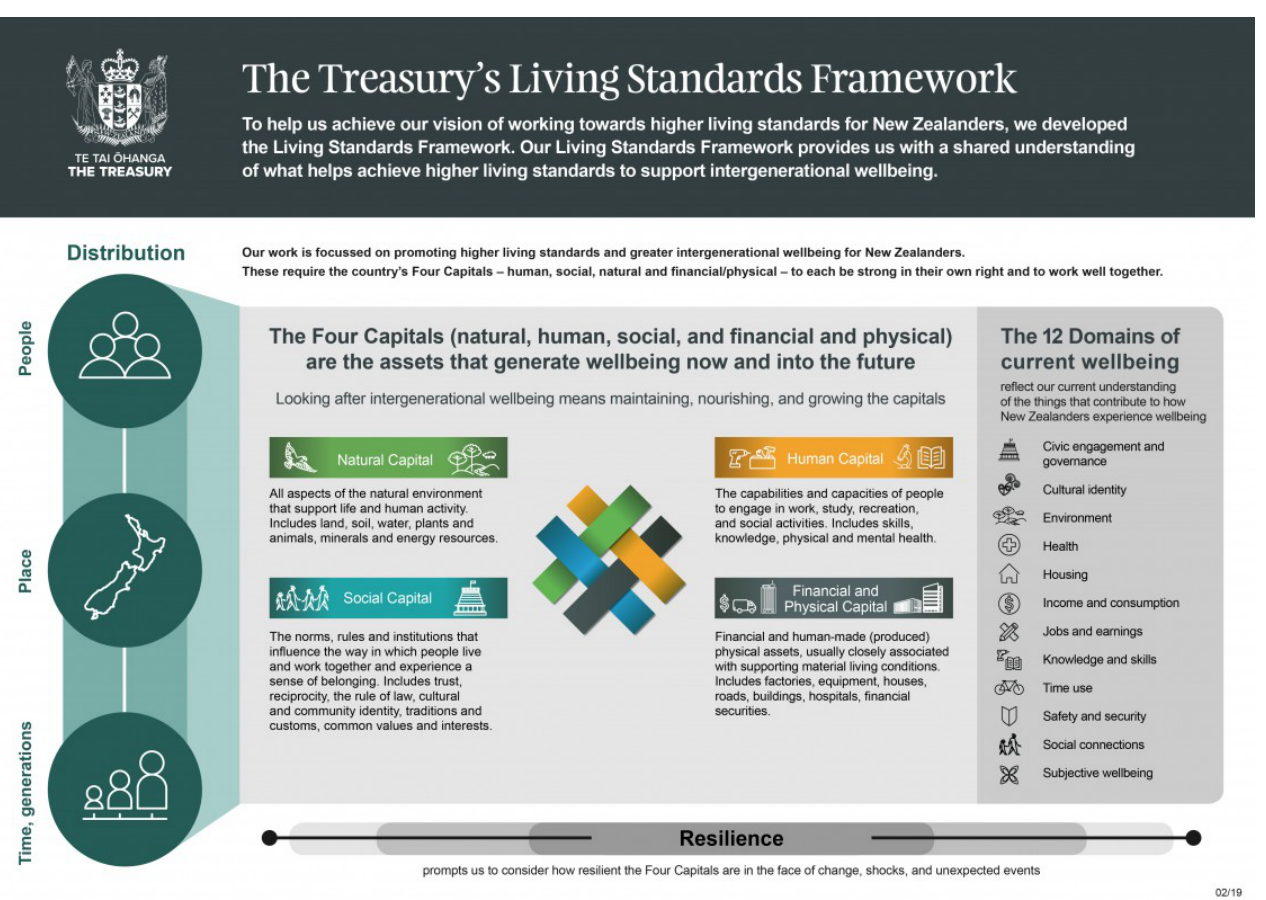
Fig. 1 . Living Standards Framework (New Zealand Treasury